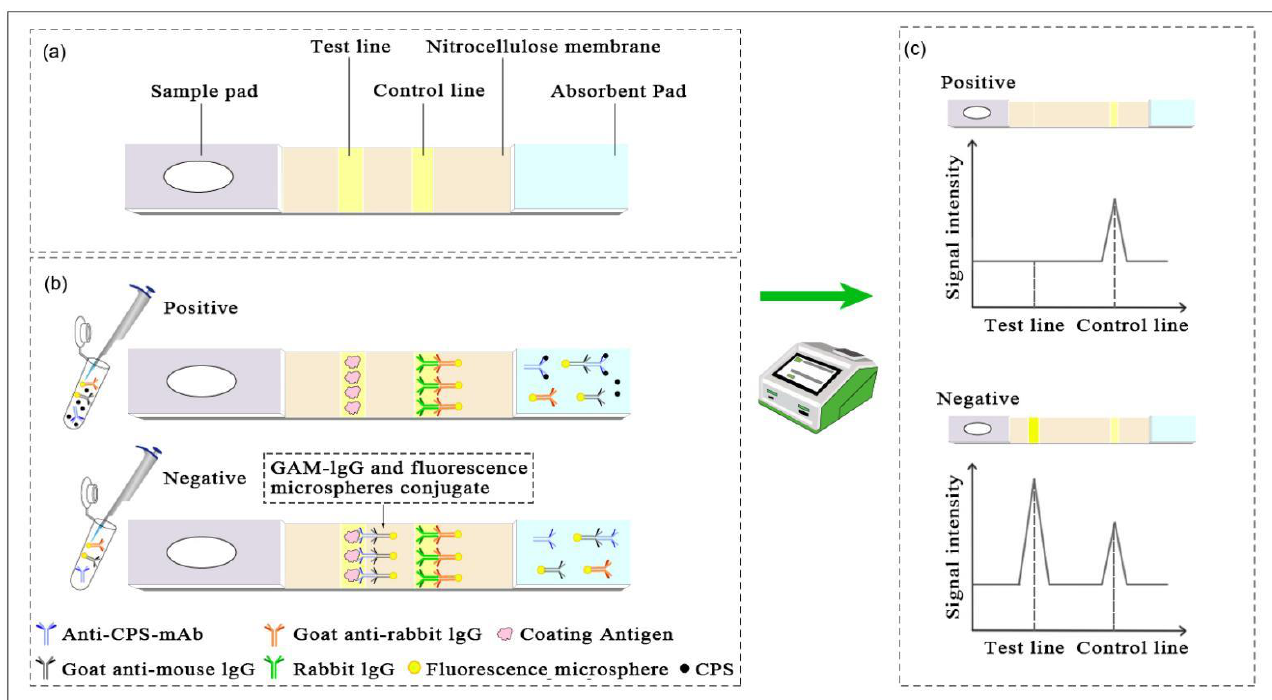
Scheme 1. Schematic illustration of the FICA detection process of CPS. ( a ) The composition of FICA. ( b ) The detection process of FICA. ( c ) The detection results of FICA.